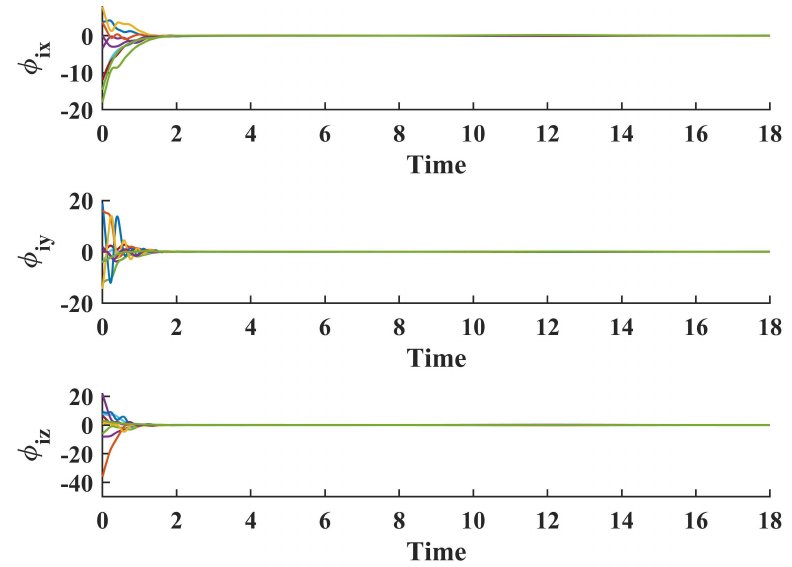
Figure 7. Velocity errors in x , y , and z directions.